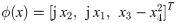
CGS process of systems (12) and (25) with respect to the given complex map vector ϕ(x)=[j x2,  j x1,  x3−x42]T.(a) x2,i, y1,r; (b) x2r, y1,i; (c) x1,i, y2,r; (d) x1,r, y2,i; (e)x3−x42, y3.